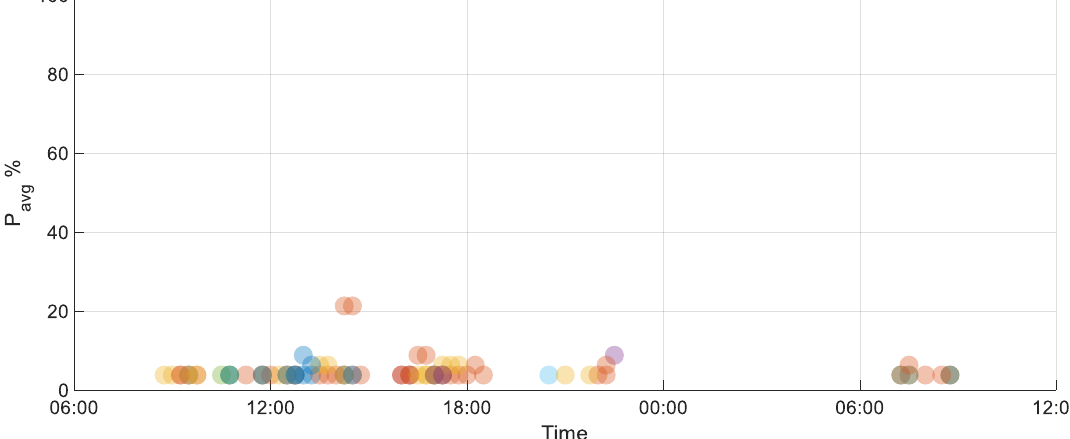
Figure 3. P avg (as a percentage of the available maximum) for 24 h (starting and ending at 8.30 Am.). Each color identifies a 5G NR BS. For illustration purposes, only samples reporting P avg larger than 2.5% are plotted. No dots are shown between midnight up to about 6 Am. indicating that all BSs were operating at a cell-wide power level below 2.5% of the maximum.